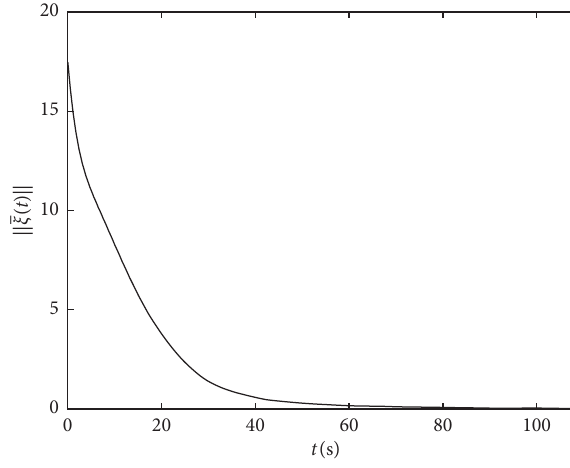
Figure 11: Evolution of ‖ ξ ( t )‖ when τ �